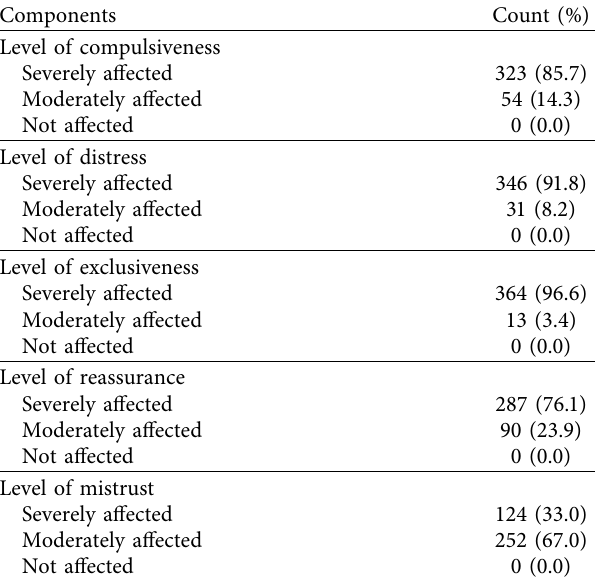
Table 5: Prevalence of different constructs of